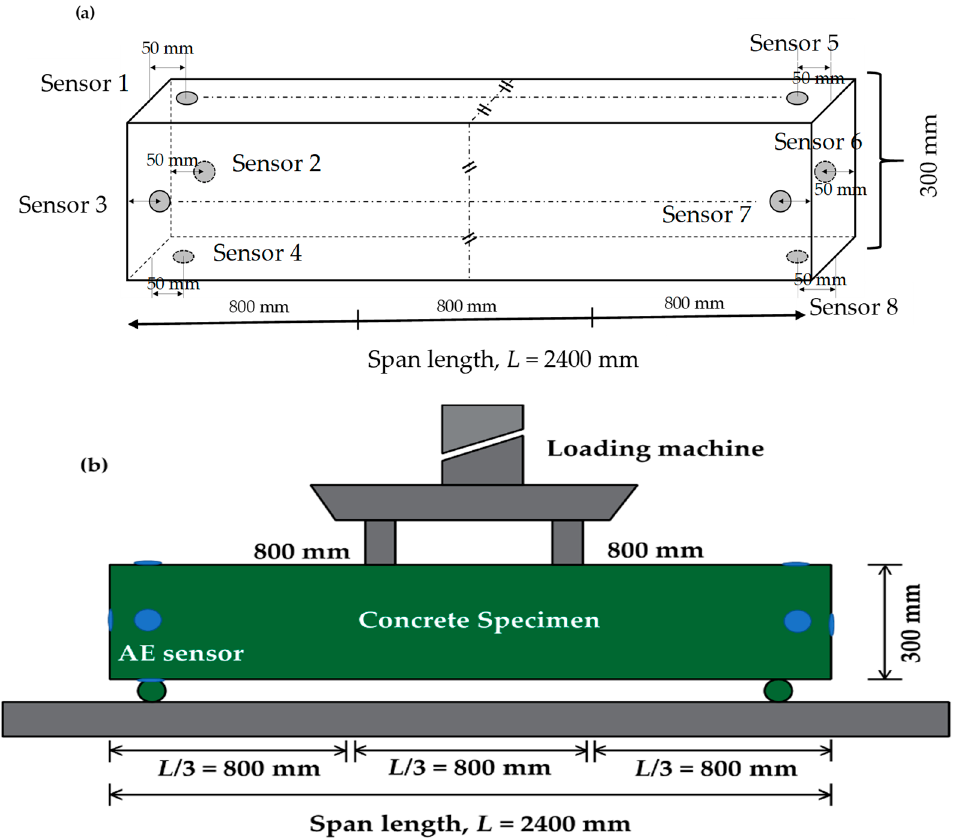
Figure 4. Schematic diagrams of the testbed: ( a ) the sensor placement, and ( b ) the three-point bending test for the beam.